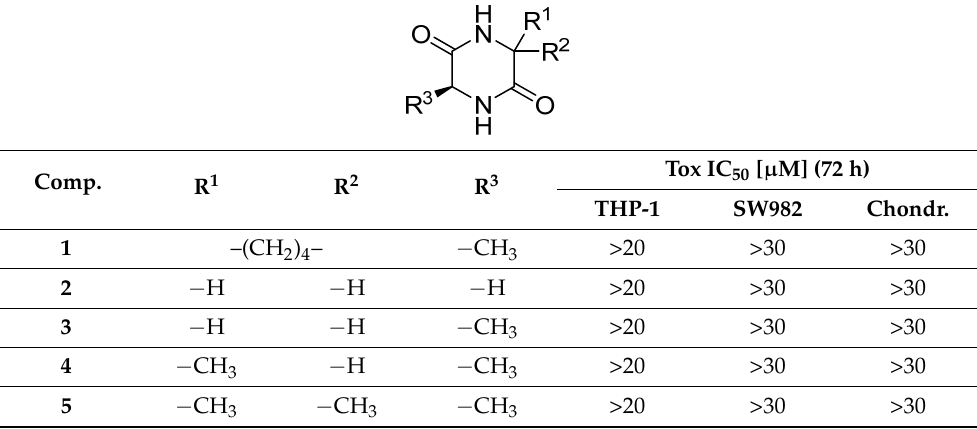
Table 1. Structure and values of viability of THP-1, SW982, and primary porcine chondrocytes (Chondr.) assays [IC 50 ( µ M) after 72 h incubation] of investigated compounds—alaptide ( 1 ) and its derivatives 2 – 5 .